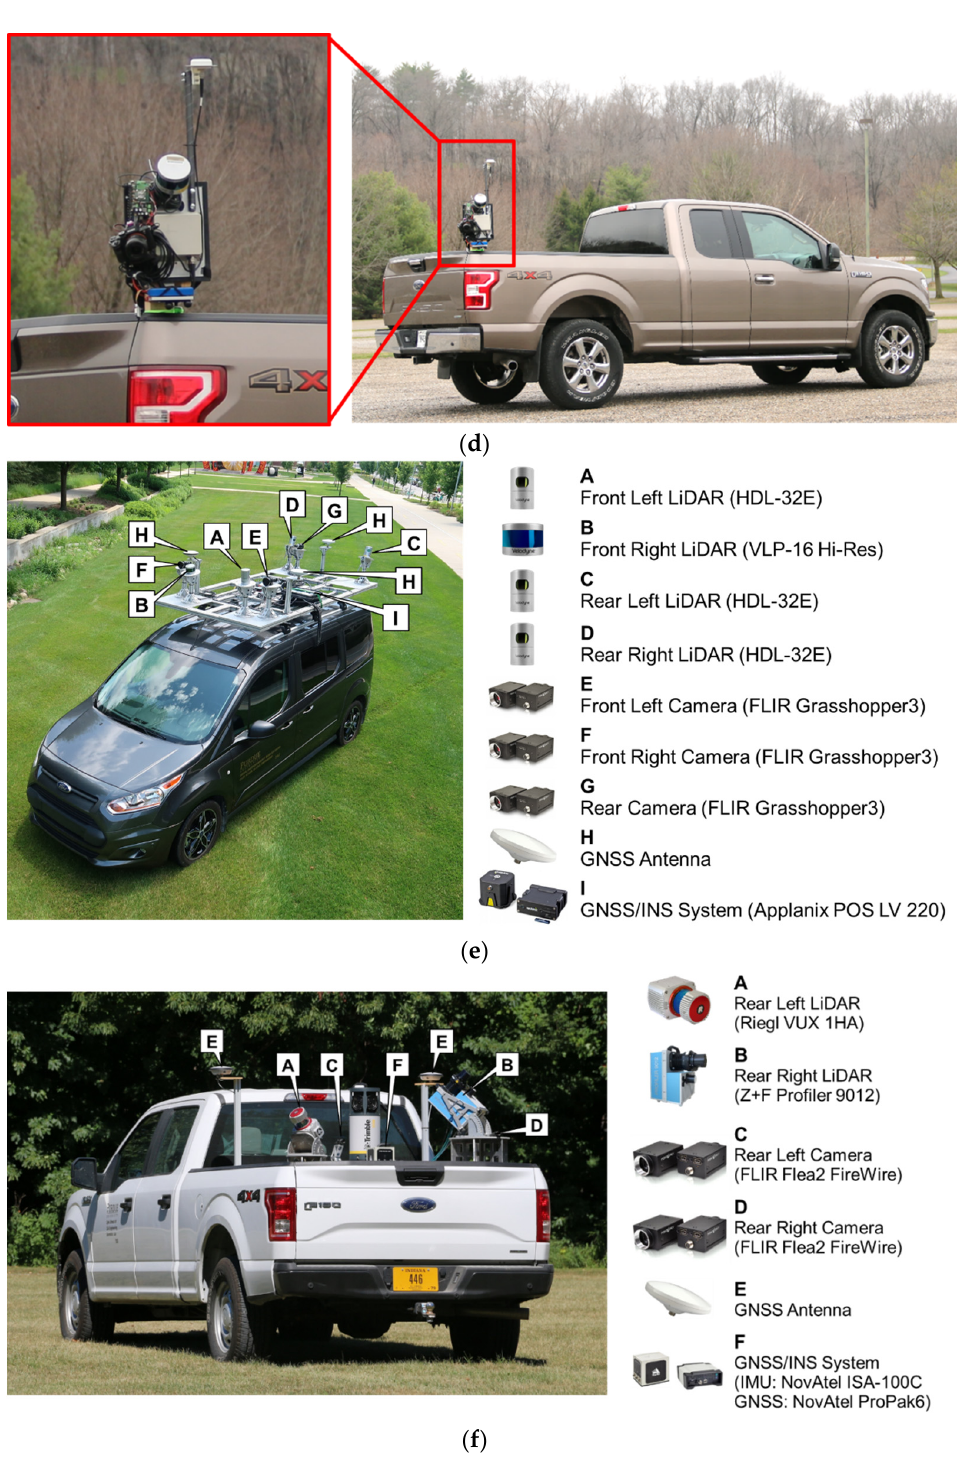
Figure 1. MLMS units used in this study: ( a ) unmanned aerial vehicle (UAV), ( b ) unmanned ground vehicle (UGV), ( c ) Backpack, ( d ) Mobile-pack, ( e ) medium-grade system (PWMMS-HA), and ( f ) high-grade system (PWMMS-UHA). All of these platforms are non-commercial systems designed and integrated by the research group.